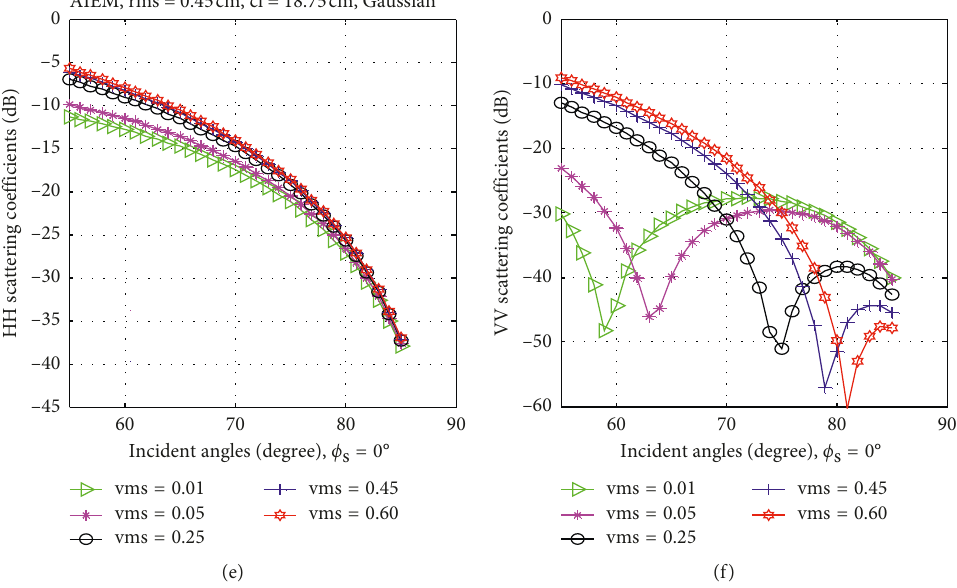
Figure 4: Scattering coefficients of different vms vs. the incident angles.